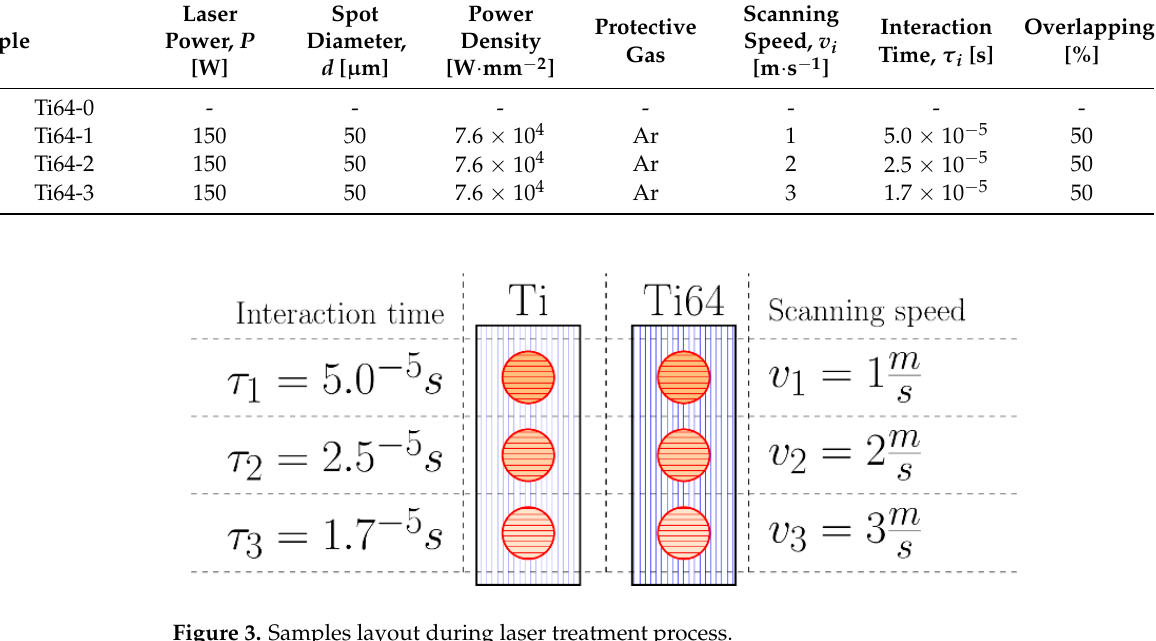
Figure 4. ( a ) Cold-sprayed coatings (Ti on the left and Ti64 on the right-hand side), ( b ) One of the laser surface treated areas.